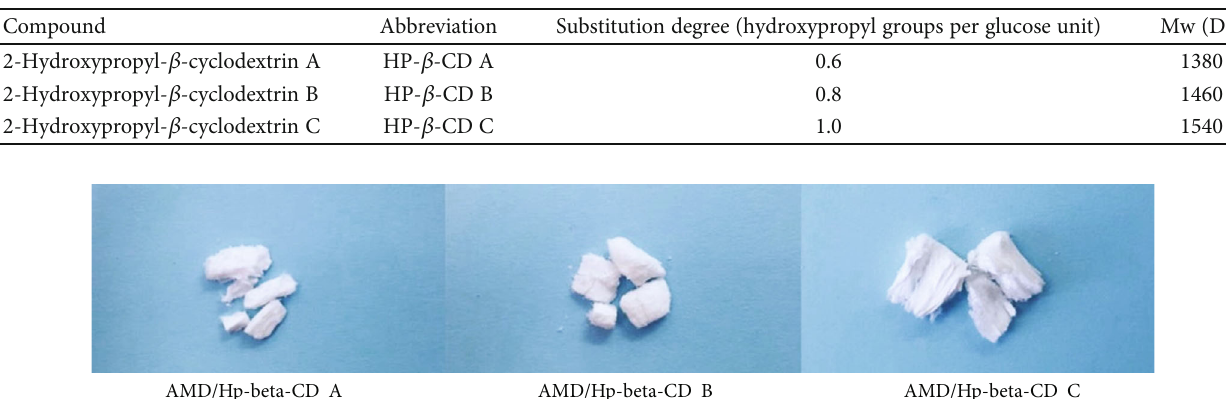
Table 1: Characteristics of the HP- β -CD and codes of the samples.